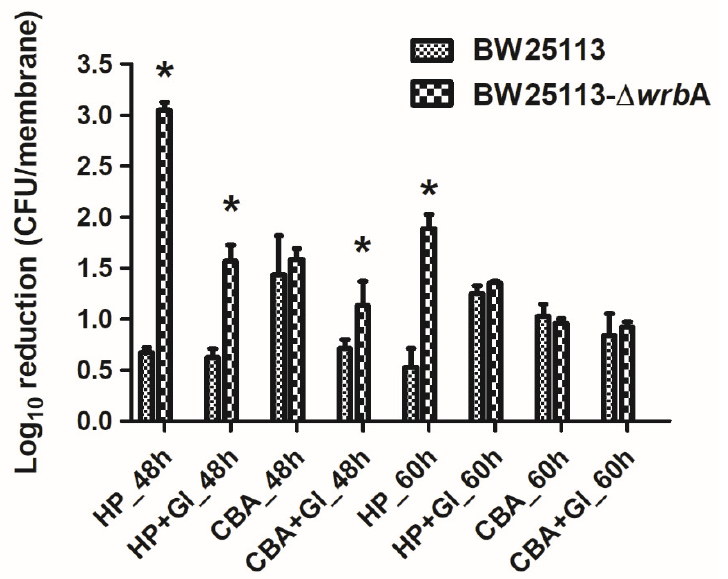
Figure 6. Susceptibility of BW25113 and BW25113- ∆ wrb A biofilms to antimicrobial agents, observed as a log 10 reduction in the number of CFUs after exposure to 6 mM 2-chlorobenzoic acid (2-CBA) and 4.5 mM H 2 O 2 (HP) with and without glutathione (Gl). Data are shown as the means ± standard deviation from three independent measurements. The asterisks indicate statistically significant differences (t-test, p ≤ 0.05) between the two strains.